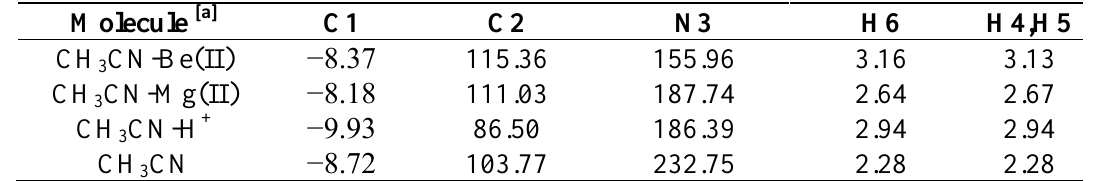
Table 5. 1 H- and 13 C-NMR shifts (ppm) of acetonitrile and its complexes with Be(II), Mg(II) and H +